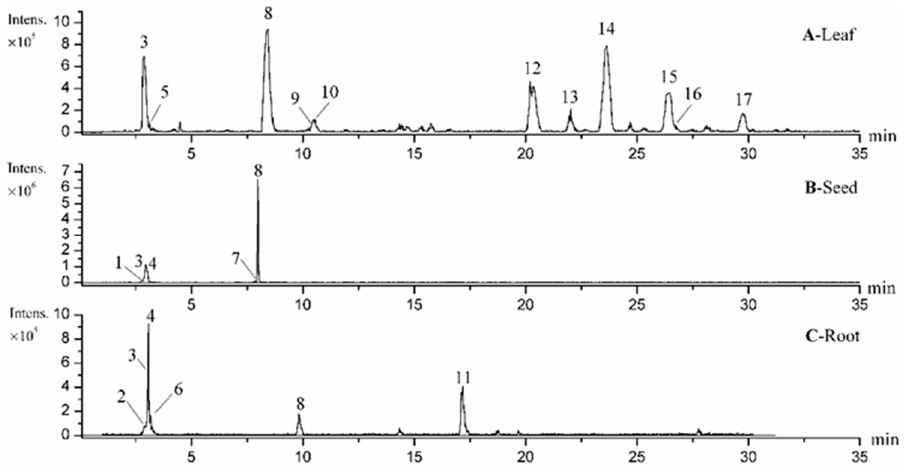
Figure 2. The base peak chromatogram (BPC) of M. oleifera leaves (A), seeds (B) and roots (C) extracts by LC-MS analysis in the negative ion mode.